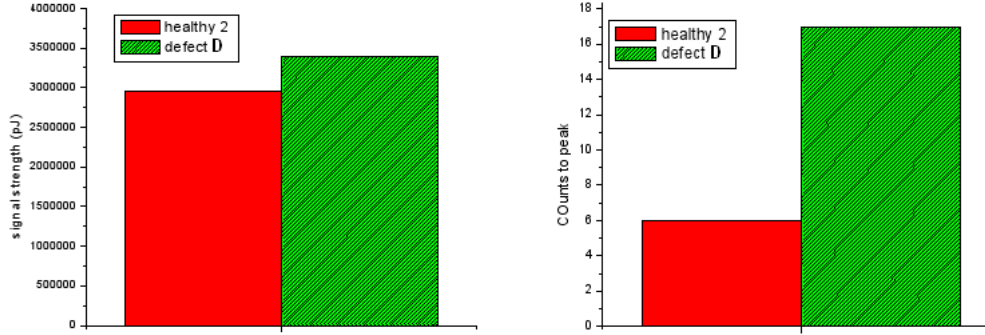
Figure 7. Sensor placement for defect D assessment.